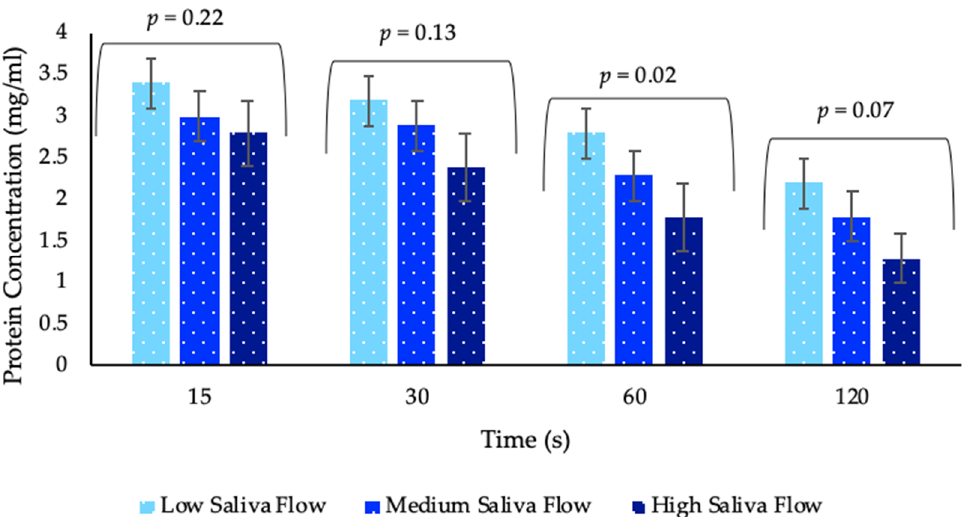
Figure 7. Protein concentration in saliva samples post whey protein beverage consumption by timepoints and saliva flow groupings. Values are expressed as LSM estimates ± standard error from SAS output. Significant differences (p < 0.05) were reported only at 60 s with relevant p value above each timepoint. Data from visit 2 (n = 84) and visit 3 (n = 82) combined. Individual saliva flow groupings are derived from unstimulated saliva flow only, through tertiary analysis.